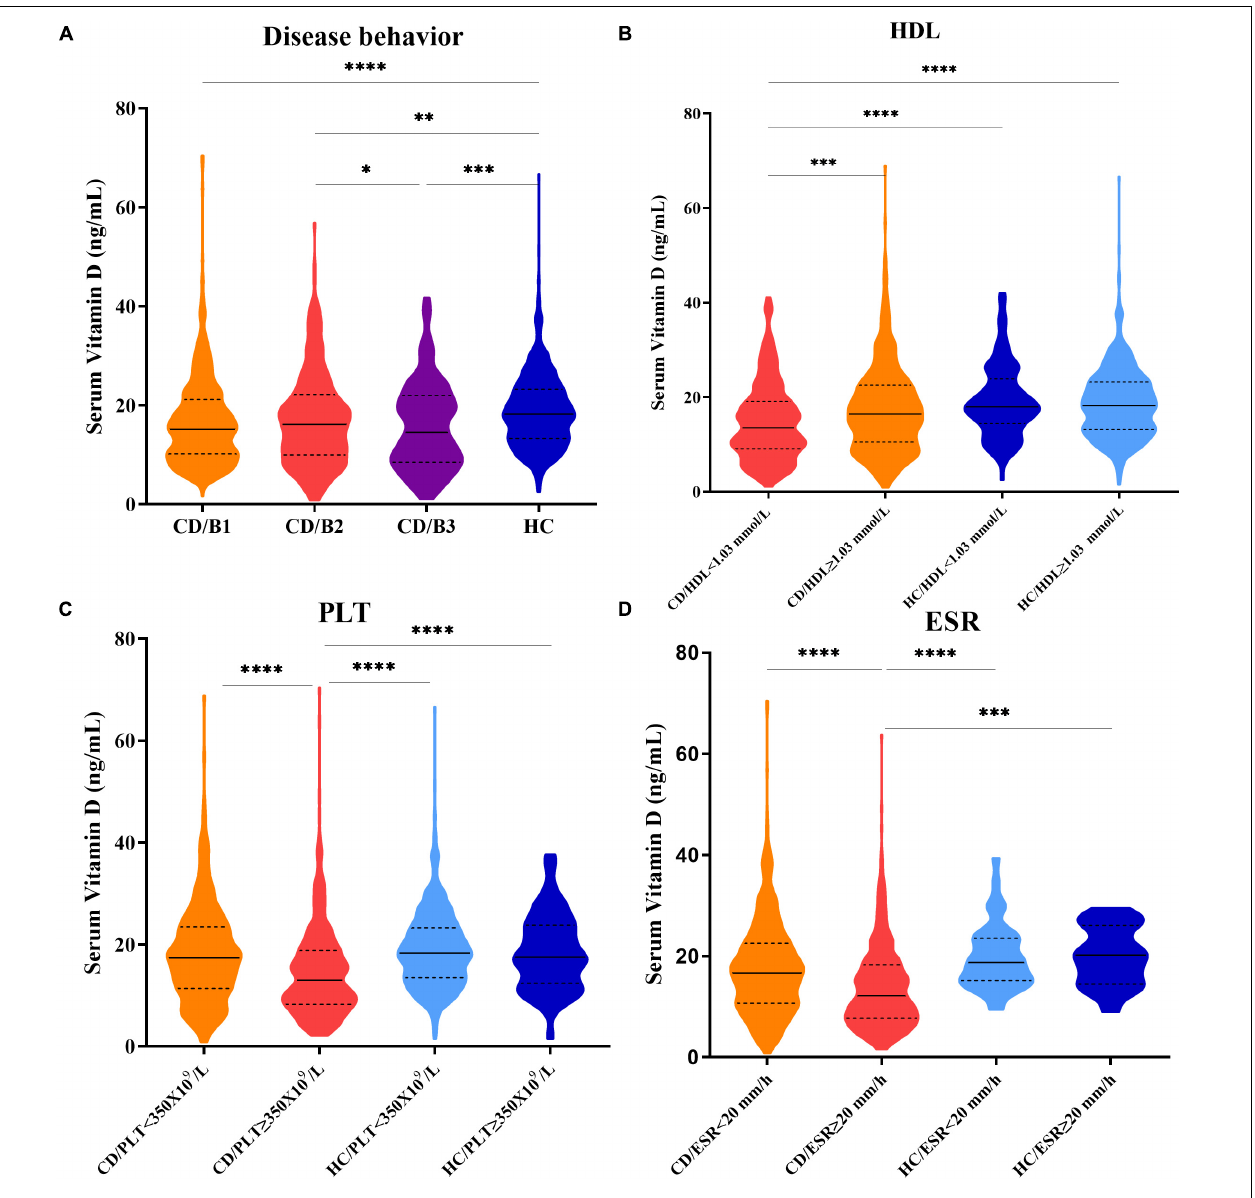
FIGURE 3 | (A) Serum vitamin D levels in patients with CD with B1, B2, B3 disease behaviors, and healthy control groups. (B) Serum vitamin D levels in CD/HDL < 1.03 mmol/L; CD/HDL ≥ 1.03 mmol/L; HC/HDL < 1.03 mmol/L; HC/HDL ≥ 1.03 mmol/L groups. (C) Serum vitamin D levels in CD/PLT < 350 × 10 9 /L; CD/PLT ≥ 350 × 10 9 /L; HC/PLT < 350 × 10 9 /L; HC/PLT ≥ 350 × 10 9 /L groups. (D) Serum vitamin D levels in CD/ESR < 20 mm/h; CD/ESR ≥ 20 mm/h; HC/ESR < 20 mm/h; HC/ESR ≥ 20 mm/h groups (one-way ANOVA analysis, ∗ p < 0.05, ∗∗ p < 0.01, ∗∗∗ p < 0.005, ∗∗∗∗ p < 0.0001).